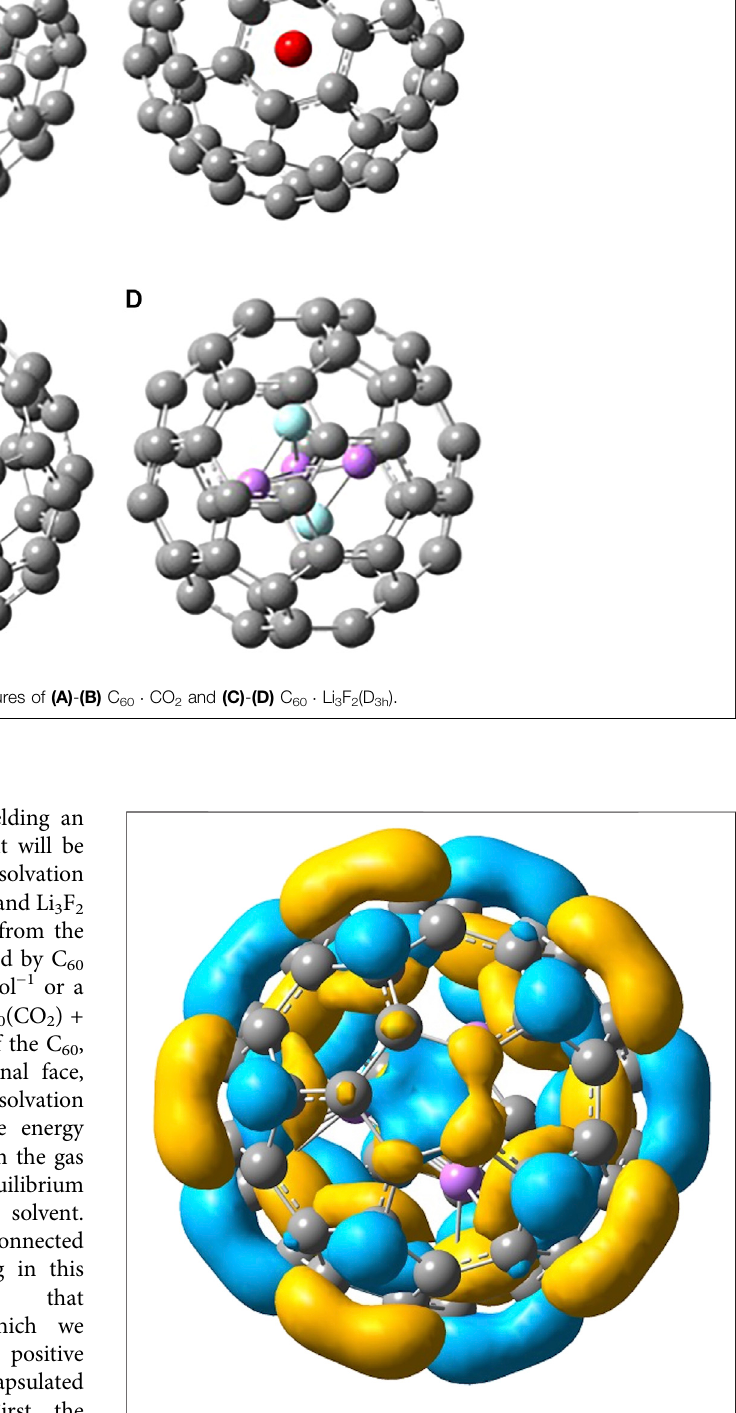
FIGURE 4 | HOMO of C 60 · Li 3 F 2 (D 3h